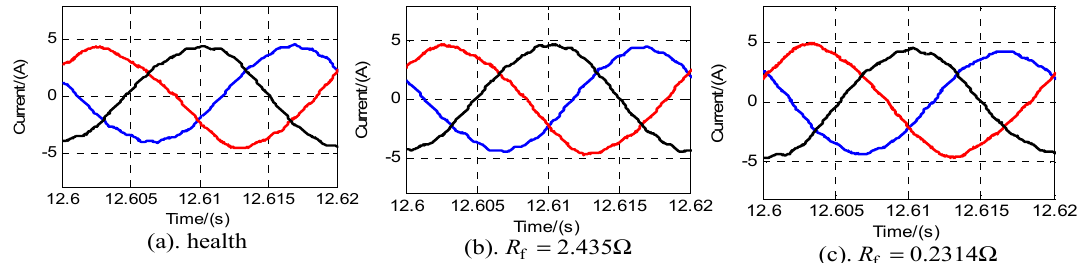
Figure 19. Stator currents of healthy, and 5-turns shorted with different short-circuit resistance in the induction motor.